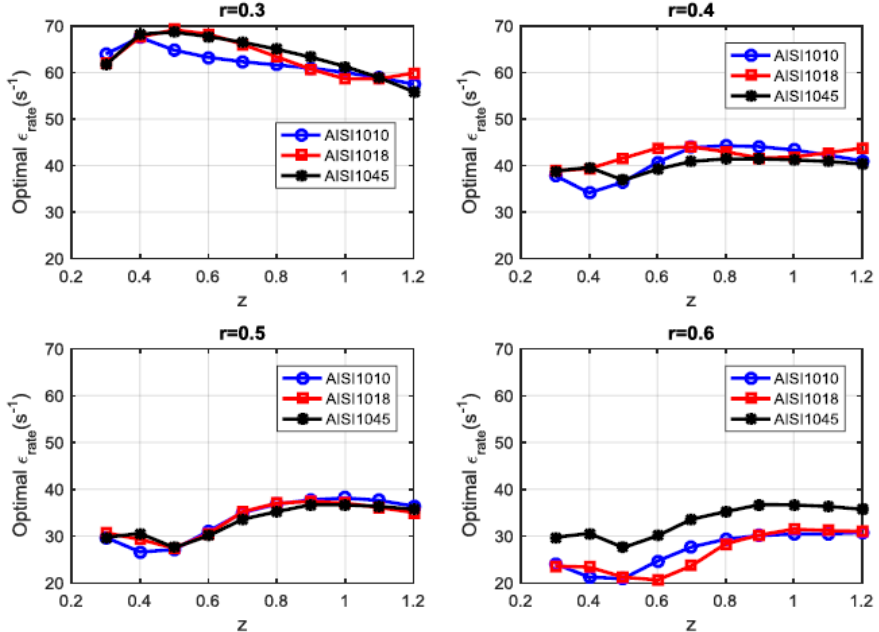
Figure 16. Comparison of optimal values of effective strain rate of different steels.